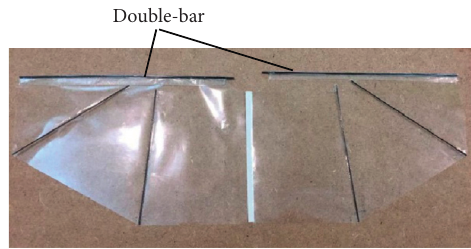
Figure 4: Double-bar wing.